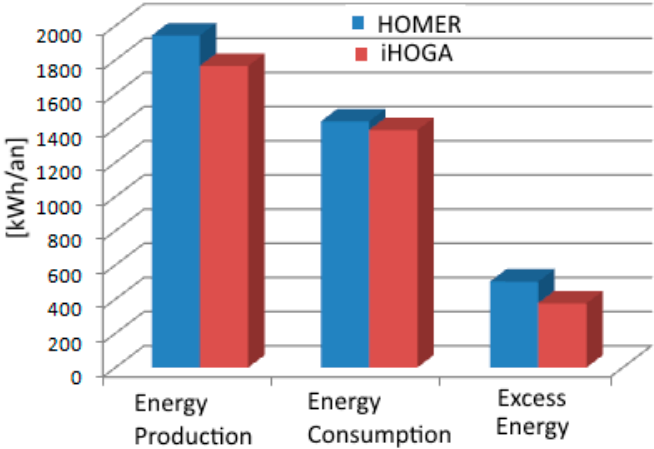
Figure 20. Electrical comparison of the two simulators.